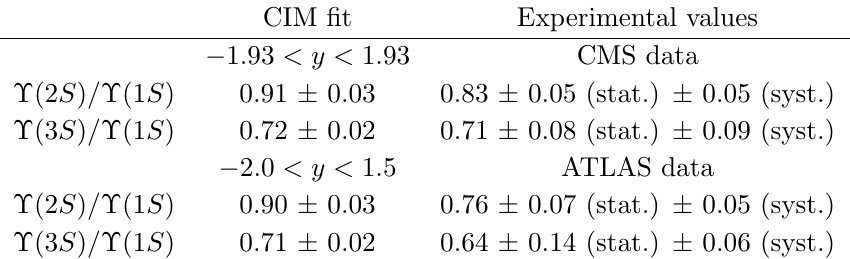
Table 3 . Measured and (cid:12)t R (cid:7)( mS ) = (cid:7)( nS )